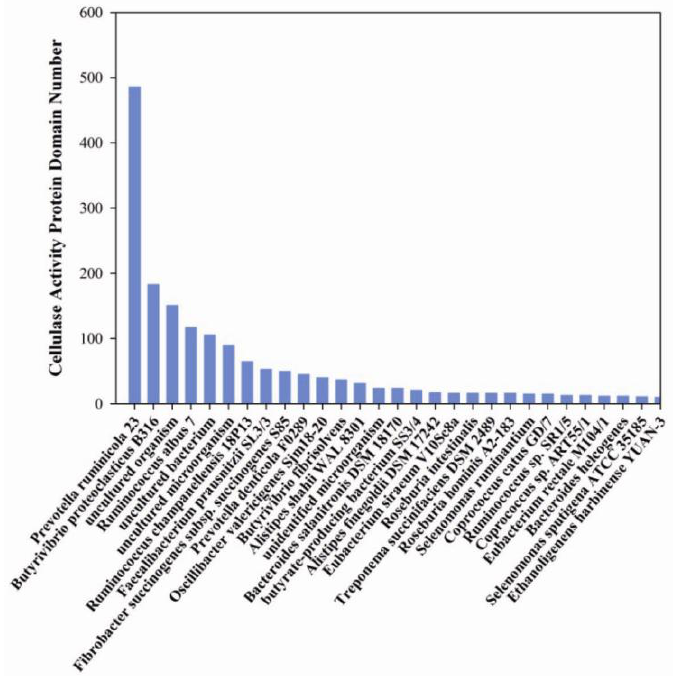
Supplementary Figure 3. Protein domains with cellulase activity were present in over 1% of the dominant microbe